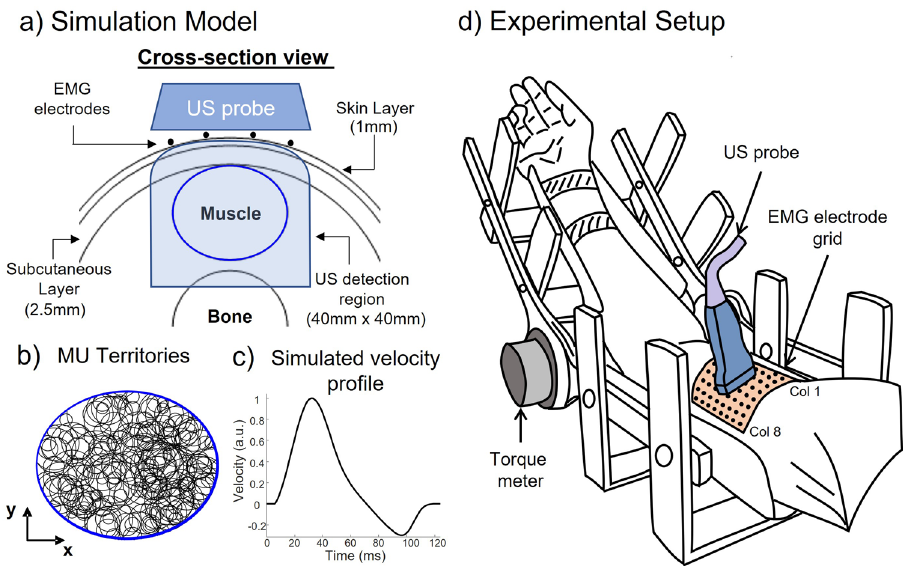
Figure 2. ( a ) Simulation model. Cross-section of the Cylindrical volume conductor model of the limb: 1 mm skin layer, 2.5 mm subcutaneous layer and elliptical-shaped muscle (598 mm 2 physiological cross-section area). The blue-shaded area is the US detection region (40 mm × 40 mm), including the whole muscle. ( b ) Distribution of MU territories (area range 5–44 mm 2 ) inside the simulated muscle. ( c ) Normalized velocity profile of the tissue velocity simulation model. ( d ) Experimental setup overview. The right arm was positioned inside an isometric brace for torque measurements. A grid of 64 EMG electrodes (8 × 8, 1 cm inter-electrode distance) was placed over the biceps brachii. The US probe was positioned between the two central rows of the electrode grid.